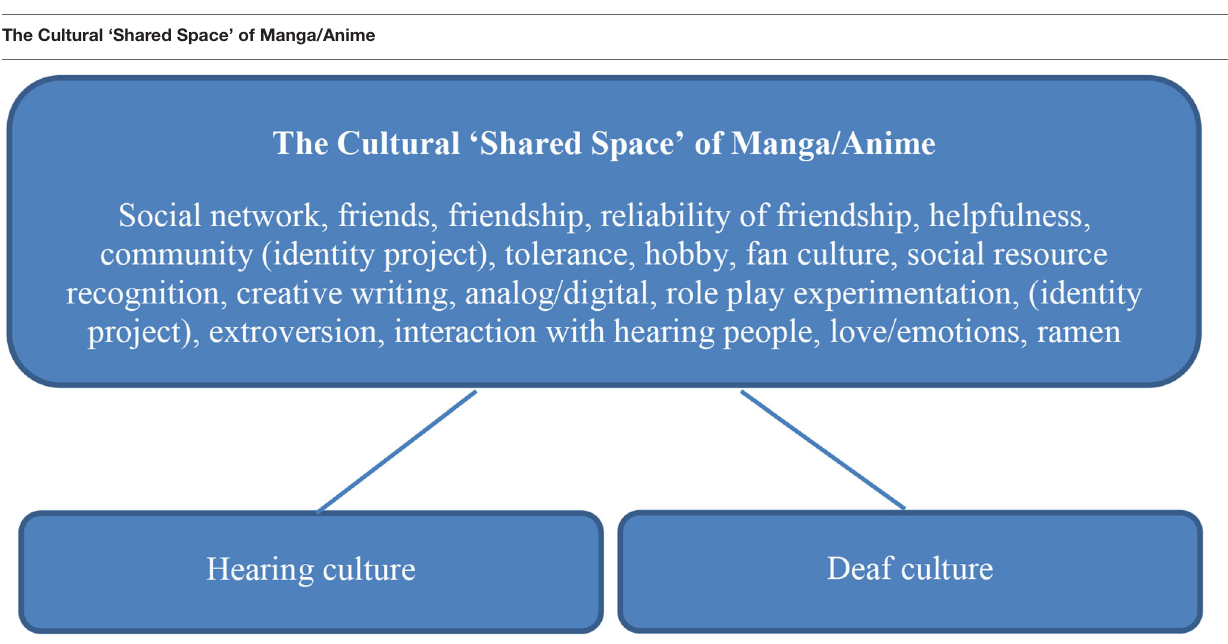
TABLE 2 | The Cultural “Shared Space” of Manga/ Anime Between Hearing and Deaf Cultures. The Cultural ‘Shared Space’ of Manga/Anime